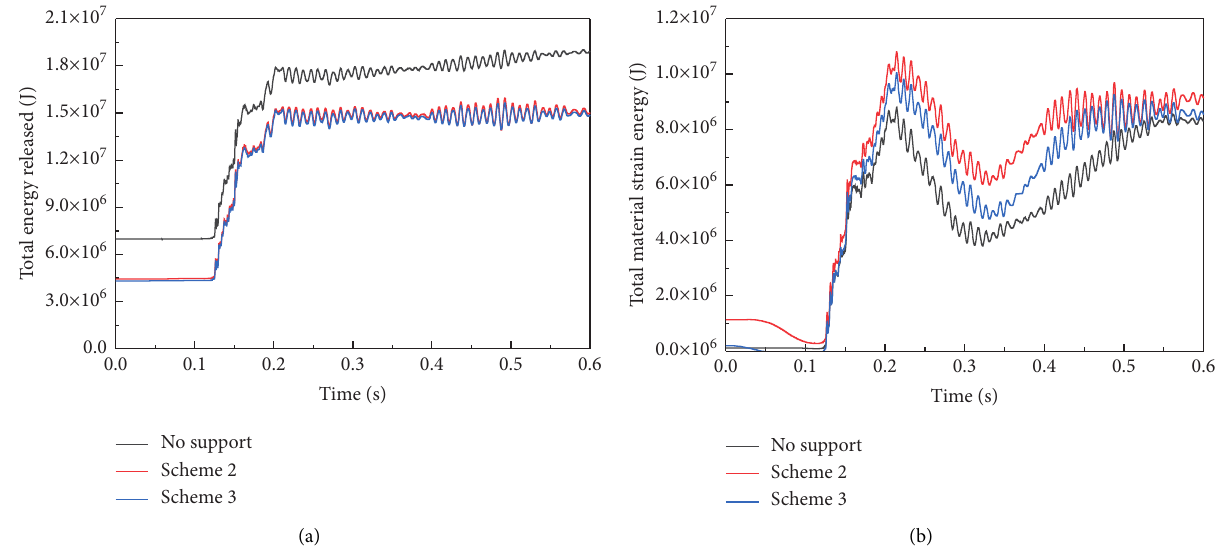
Figure 17: Energy of roadway with different support schemes. (a) Total energy released. (b) Total material strain